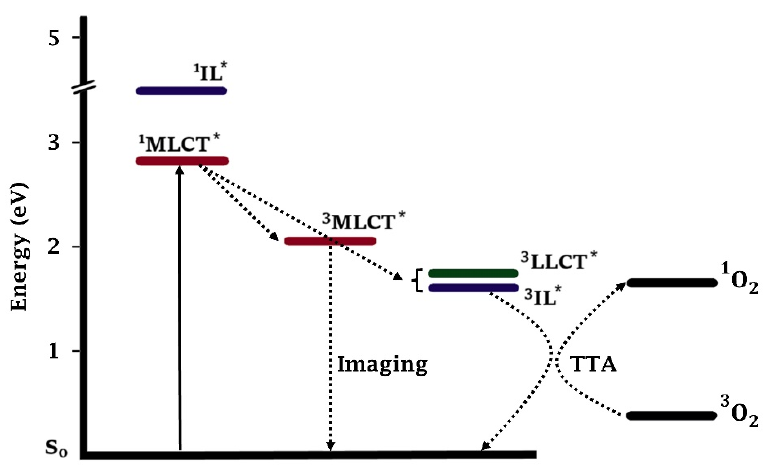
Figure 9. Energy level diagram describing the photosensitizing process of TLD-1433 [37].